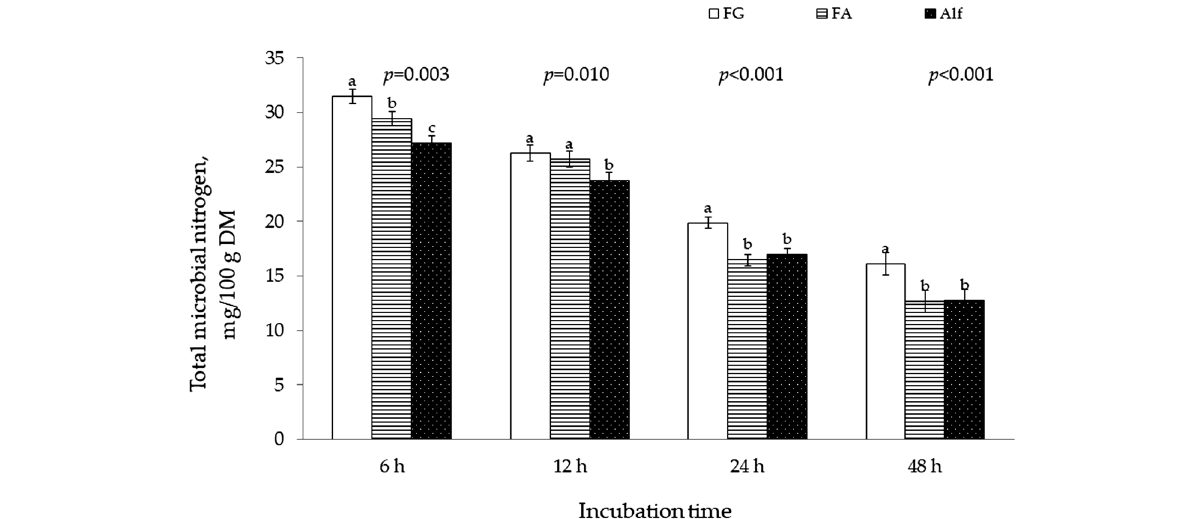
Figure 1. Microbial N production of fenugreek (FG) harvested at 11 wk, alfalfa (Alf) harvested at early bloom and their 50:50 mixture (FA) during 48-h in vitro ruminal incubation.